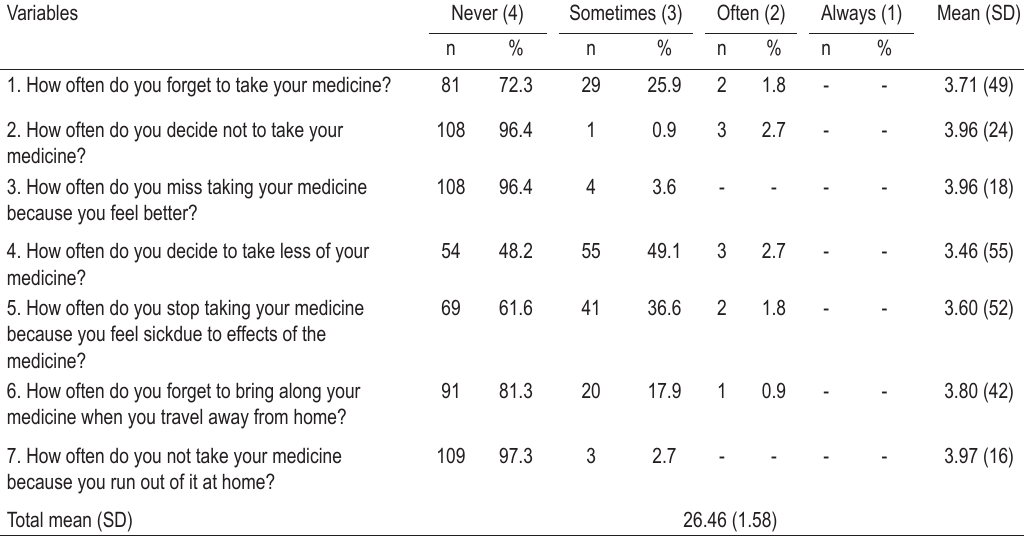
TABLE 3. Distribution of medication adherence among the participants